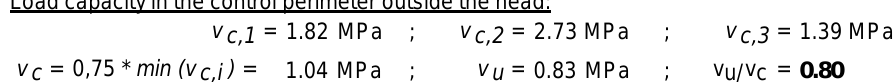
Figure A6. Verification example no. 2—ACI 318.